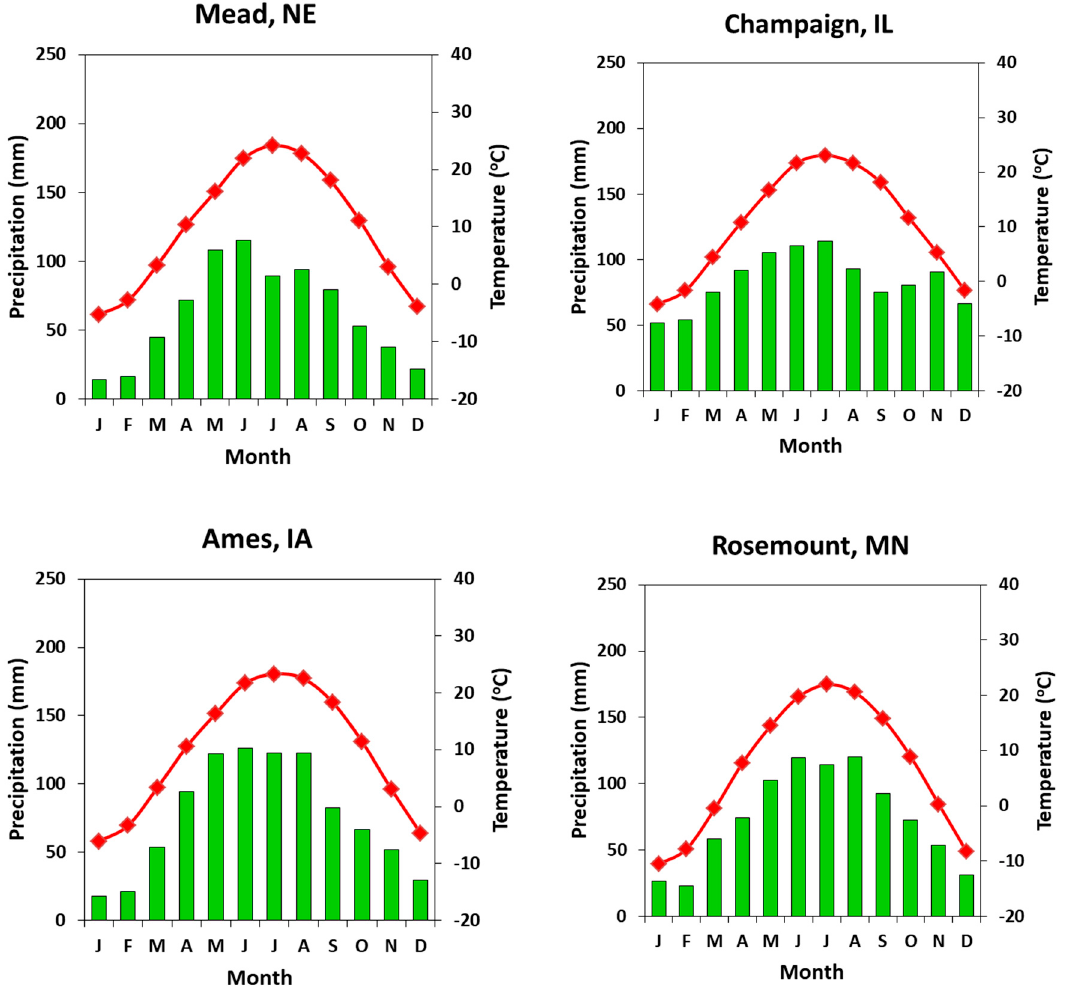
Figure 2. Climographs from cities near the AmeriFlux sites. US-Ne1, US-Ne2, and US-Ne3 are located at the University of Nebraska’s Eastern Nebraska Research and Extension Center near Mead, NE; US- Br1 and US-Br2 located approximately 8 km southwest of Ames, Iowa; US-Bo1 is located approximately 12 km south of Champaign, Illinois and US-Ro1 is located near Rosemount, Minnesota which is located approximately 24 km south of Saint Paul, Minnesota. (Source: 1981–2010 normals, usclimatedata.com) .